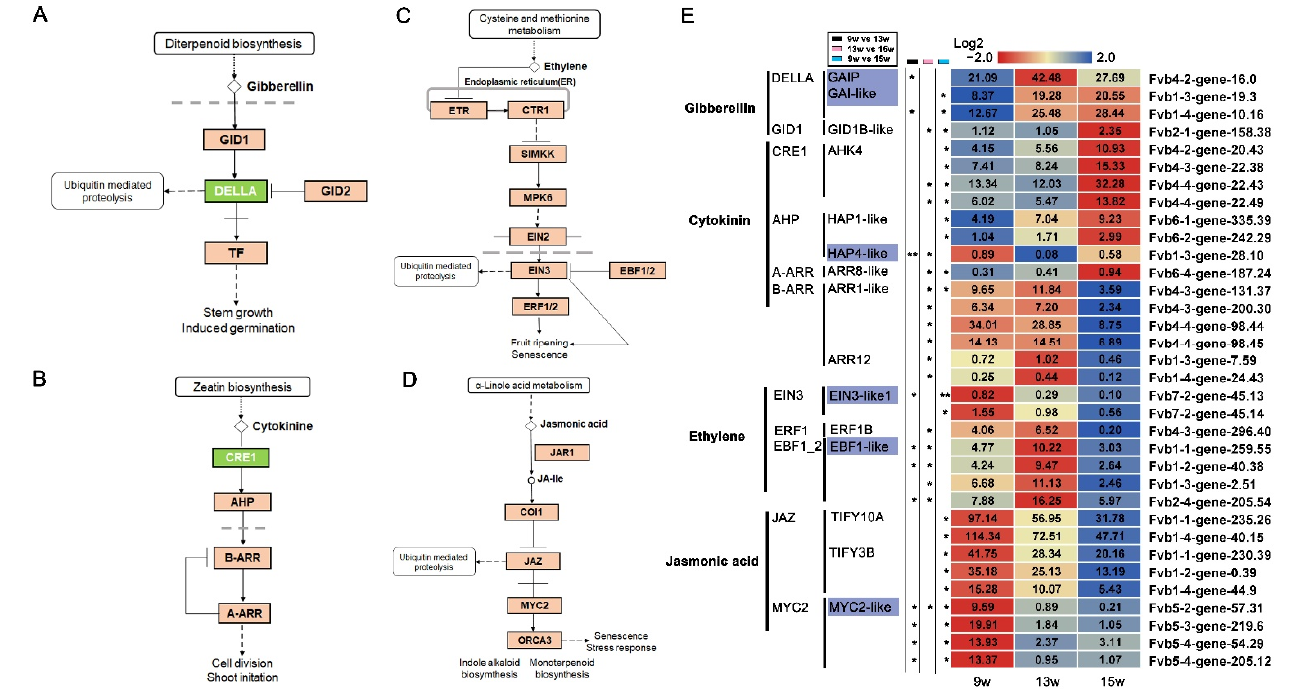
Figure 8. DEGs involved in gibberellin, cytokinin, ethylene, and jasmonic acid signaling pathways. ( A – D ) Gibberellin, cytokinin, ethylene, and jasmonic acid signal transduction pathways by referring to the KO04075 pathway in KEGG enrichment analysis. ( E ) Heatmaps showing the relative expression of DEGs involved in the above-mentioned hormone signaling pathways. The purple boxes indicate the genes in which expression was significantly changed by 9 w vs. 13 w. 9 w: vegetative stage, 13 w: shifts to reproductive stage at gene level, 15 w: reproductive stage. The column with the black boxes represents the student’s t test analysis of DEGs by 9 w vs. 13 w; The column with the pink boxes represents the student’s t test analysis of DEGs by 13 w vs. 15 w; The column with the blue boxes represents the student’s t test analysis of DEGs by 9 w vs. 15 w. (* |Log2FC| ≥ 1, p < 0.05. ** |Log2FC| ≥ 2, p < 0.01).